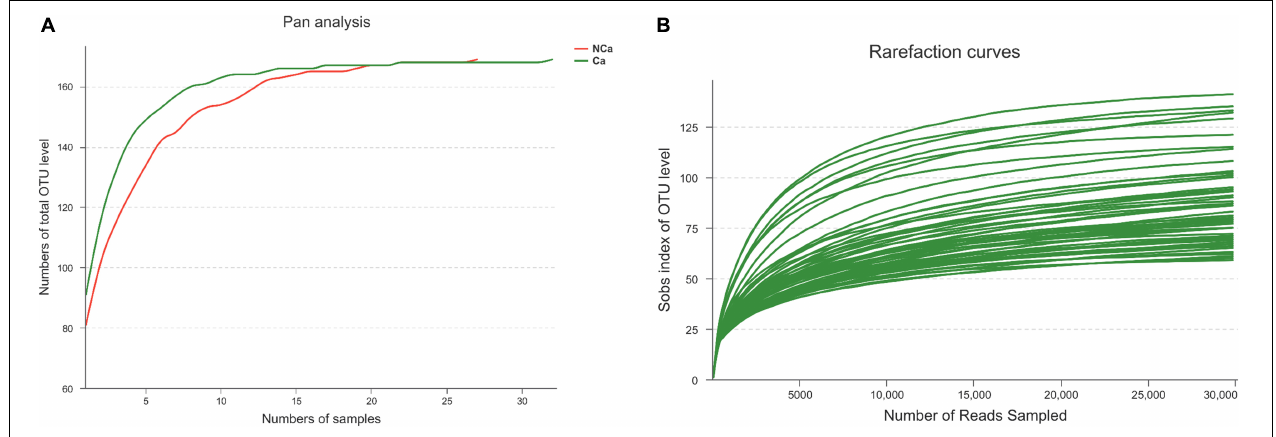
FIGURE 1 | Prostate 16S ribosomal RNA gene sequencing data analysis. (A) Number of total OTUs in all samples. (B) The Sobs index of the OTU levels in all samples.